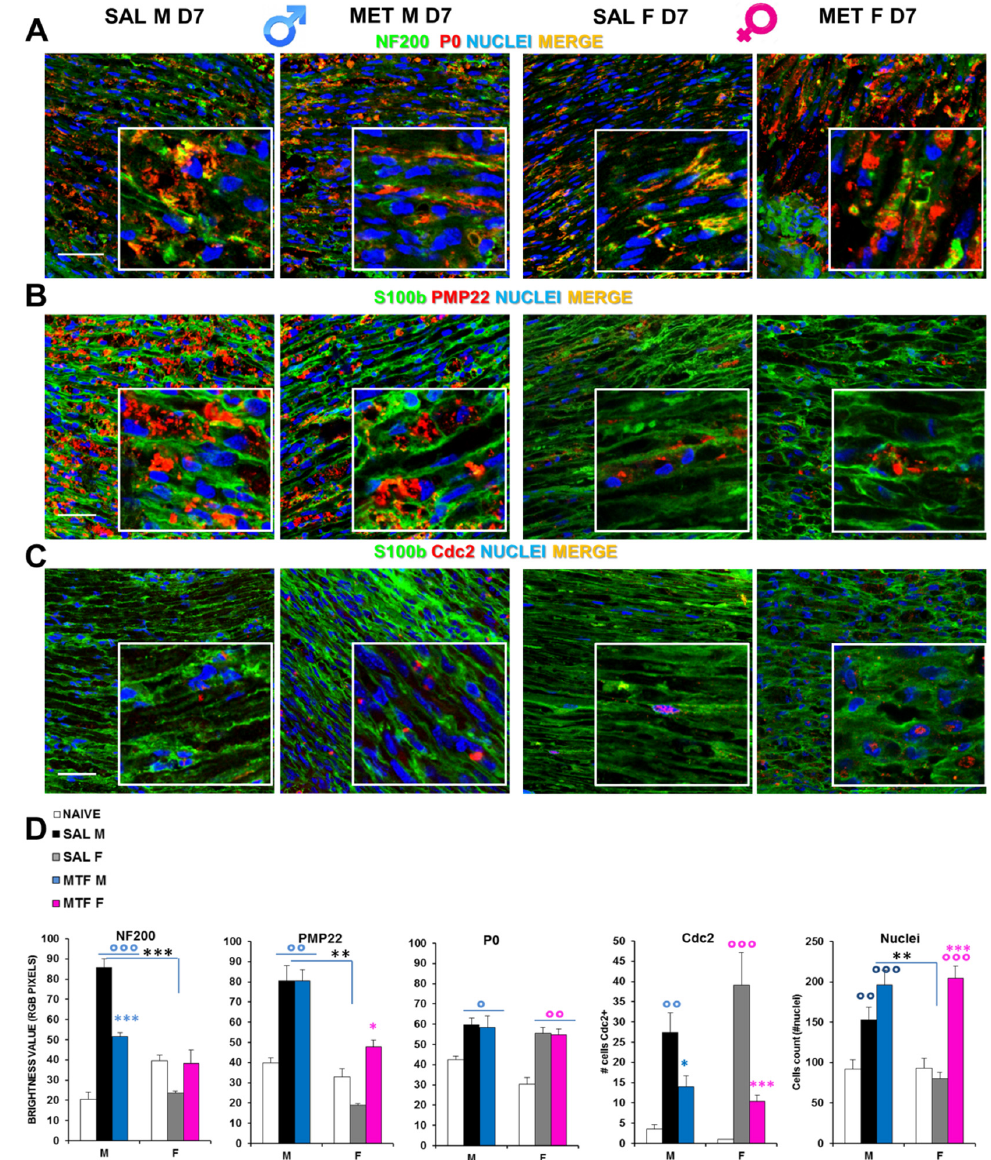
Figure 2. Effects of MTF administration on CCI-induced peripheral (sciatic nerve) neurodegeneration in male and female mice. ( A ) Representative merged confocal images (high magnification 63 × and zoom 2 × ; scale bar 50 u) of the lesioned area of the sciatic nerve stained for neurofilament 200 (NF200, green), myelin protein zero (P0, red) and nuclei (cyan); or for ( B ) Schwann cell marker, S100beta (green), peripheral myelin protein 22 (PMP22, red); or for ( C ) S100b (green) and Cell Division Cycle 2 (Cdc2, red); colocalizing proteins are yellow. ( D ) Graphs show RGB (red, green, blue) analysis transforming pixels in brightness values for NF200, P0 and PMP22 markers; the number of cells positive for Cdc2 and the total number of nuclei were counted. (n = 3/5 animals/group, 2/3 slices/animal) °, °°, °°° (blue or pink): p < 0.05, 0.005, 0.0001 respectively vs. CTRL males or females; *, **, *** (blue or pink): p < 0.05, 0.005, 0.0001 respectively vs. saline (SAL) males or females; **, *** (black): p < 0.005 and 0.0001 SAL males vs. SAL females. ANOVA for NF200:F 5,40 : 25.46 p < 0.0001; P0: F 5,45 : 5104 p < 0.0001; PMP22 F 5,40 18,196 p 0.0010; Cdc2 F 5,30 9919 p < 0.0001; Nuclei F 5,104 13,827 p < 0.0001.